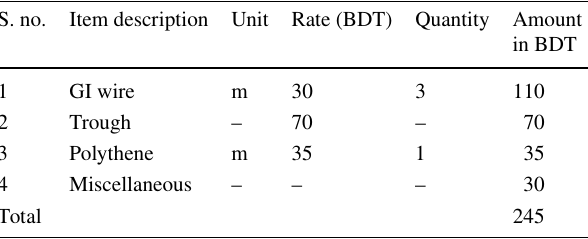
Table 2 Cost analysis for the TSS (according to 2018) Table 3 Comparison of different types of solar